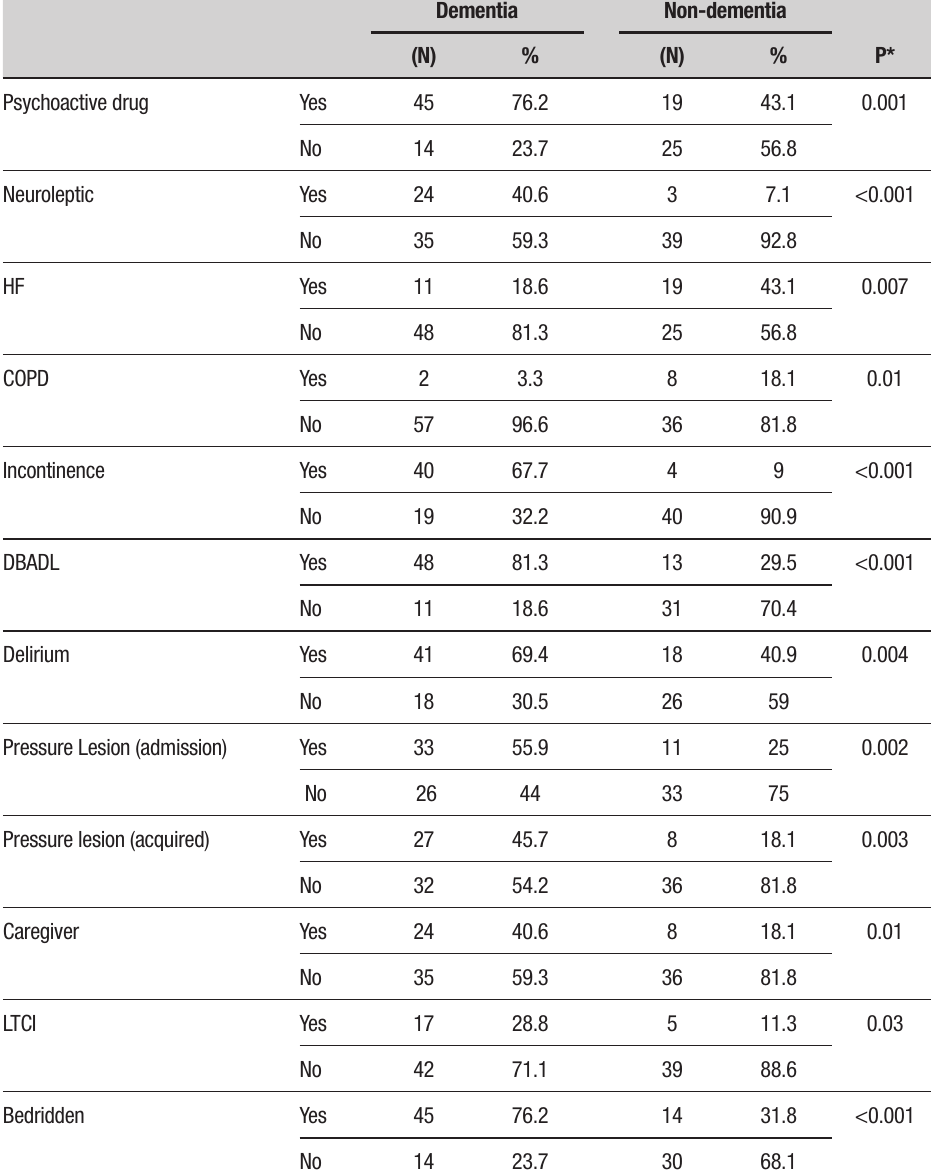
Table 4. Variables with statistically significant association between “dementia” and “non-dementia”